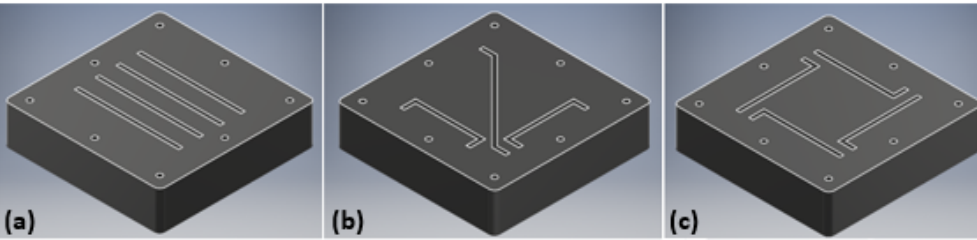
Figure 3. CAD images of three implemented MRE patterns. ( a ) Horizontal array with 4 lines; ( b ) 3-line array with 90 ◦ and 45 ◦ between them; ( c ) 4-line array with 90 ◦ between them. Figures taken from